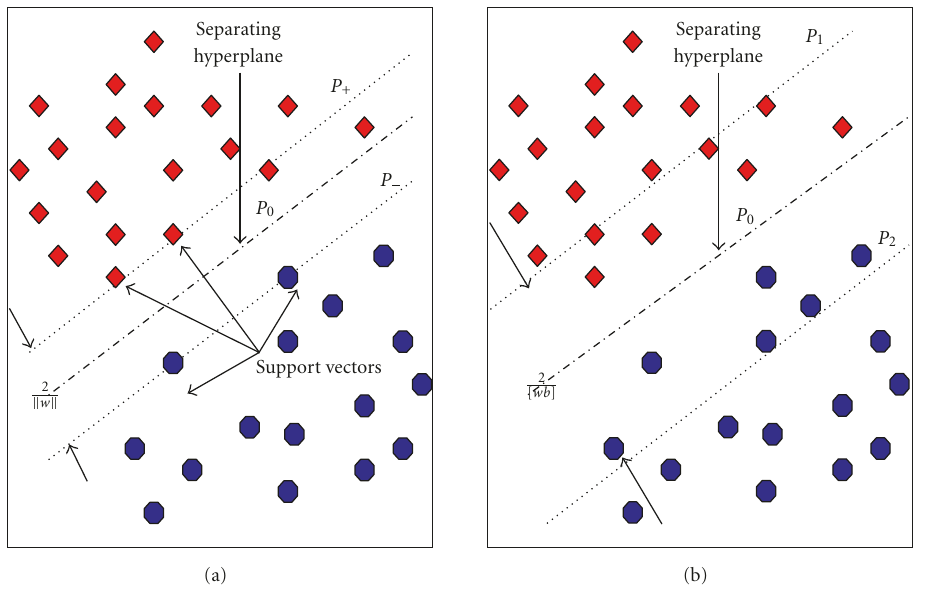
Figure 1: Standard versus proposed binary classification using regularized